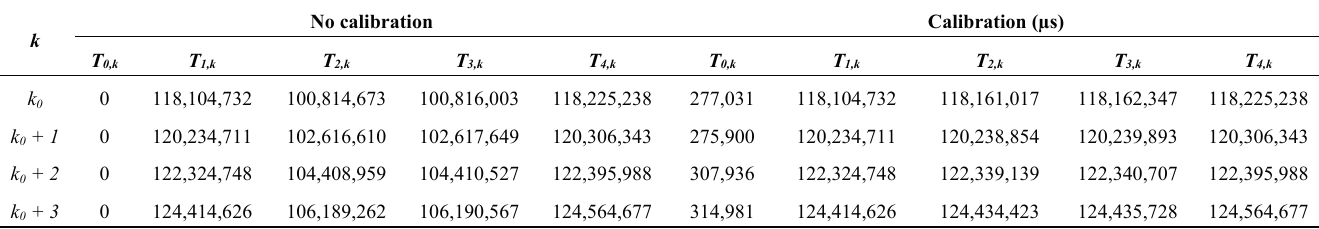
Table 1. The comparison between no calibration and calibration (time interval 2